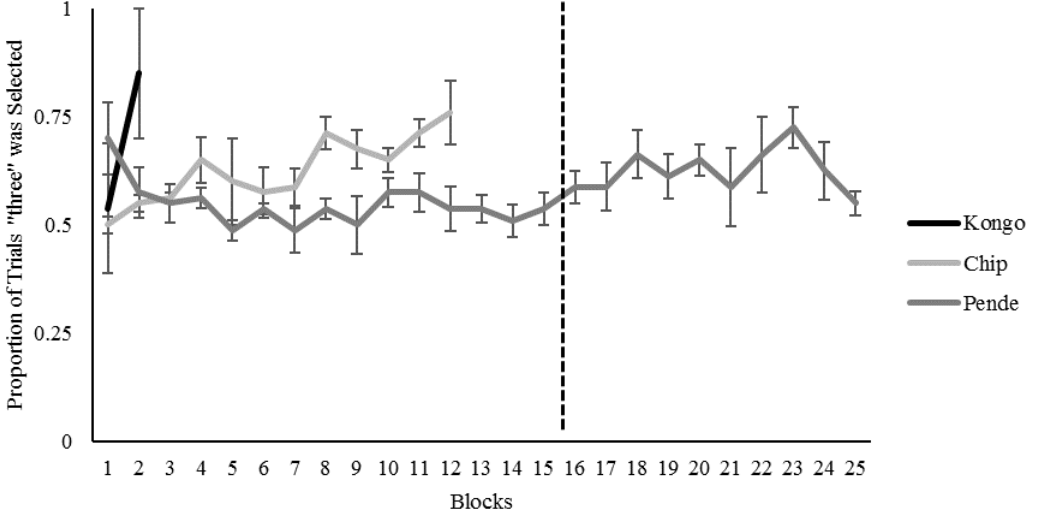
Figure 6 . Proportion of trials during the “zero versus three” task that Kongo, Chip and Pende selected the “three” stimulus across blocks of four sessions –The dotted line indicates when an incorrect buzzer was added for “zero” choices for Pende. After reaching criterion on “zero versus three,” Kongo received an additional 110 sessions (2,200 trials) of “one versus three.” Chip received 48 sessions of “one versus three” followed by 19 sessions of “one versus three” (1,340 trials total). A binomial test indicated that Chip did not select “three” at a incorrect rate above chance across all trials ( N = 1,340, p = 1.00). After 75 trials, Kongo was introduced to the “one versus three” version of the task in which selecting “one” was no longer rewarded and incorrect